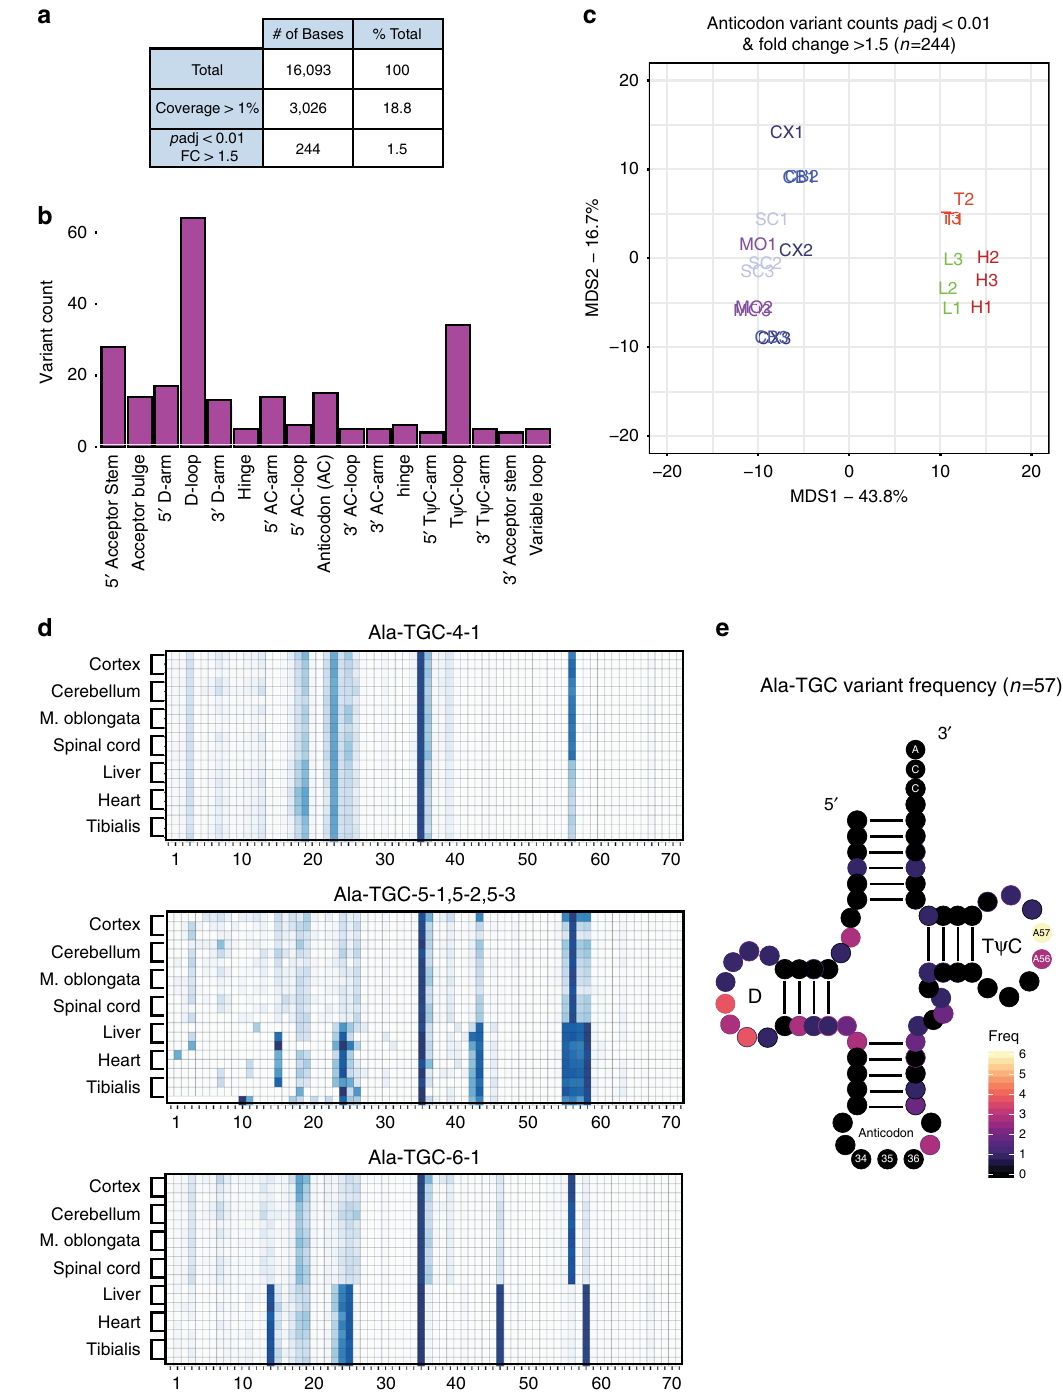
Fig. 6 Variants in sequencing change across tissues in tRNA regions known to be modi fi ed. a Tabulation of QuantM-seq variant analyses. Total represents the total number of bases in gtRNAdb mouse tRNAs. Coverage > 1% represents the number of bases that have a variant fraction (variant count / read coverage) of at least 1% across all tissue samples. The last row represents bases that are at least 1% variant fraction, change with padj < 0.01 (Two- tailed, Benjamini – Hochberg), and exhibit an absolute fold-change of >1.5 across mouse tissues. b Histogram of signi fi cantly changed tRNA bases across seven tissues in mouse. All variant bases are binned by tRNA features. c Multidimensional scaling plot indicating distance between tissue samples with regards to differential variant fractions across tissues (Euclidean distance). CNS tissues are labeled in shades of blue, non-CNS muscle tissues are in red, and the non-CNS liver is in green. d Heatmaps for three isodecoders representing variant fractions at each tRNA position ( x -axis) across each tissue sample ( y- axis). The numbers below the plot indicate nucleotide position. e Two-dimensional representation of the Ala-TGC isoacceptor class showing counts of differential variants by position ( n = 11